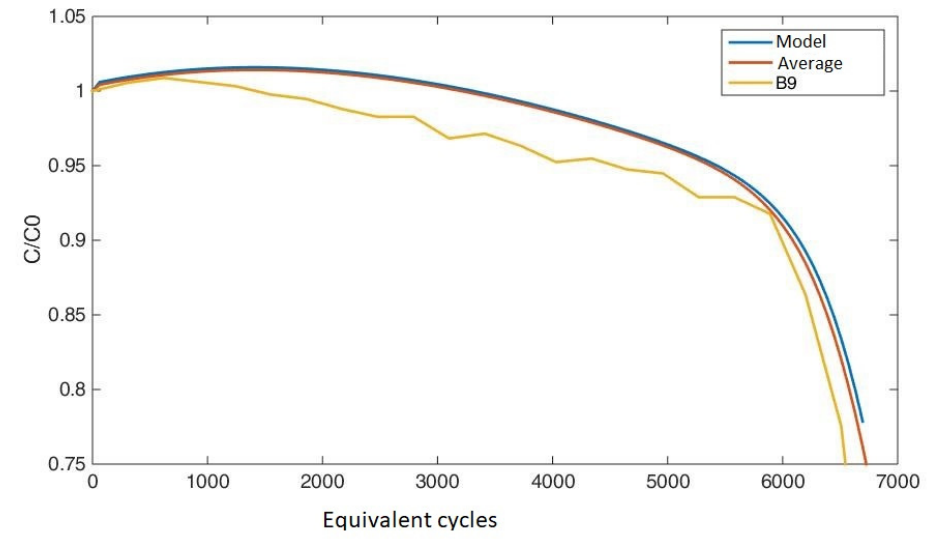
Figure 11. Comparison between the experimental curve, the extrapolation of the modified Markov model and the simulation average.